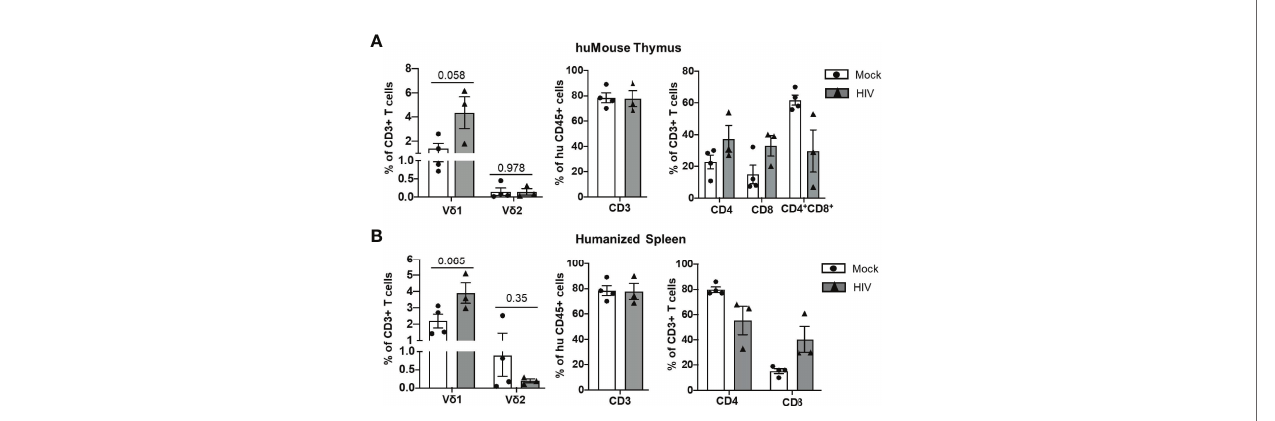
FIGURE 4 | T cell number is altered in lymphoid tissue of HIV-infected BLT huMice. (A, B) Quanti fi cation of human T cell subsets, gd T cells and ab T cells in human thymus and humanized spleen tissue of HIV-infected (n = 3 biological replicates) and non-infected (n = 4 biological replicates) BLT huMice at 4-6 weeks post-infection. Data are presented as mean values ± SEM. P values <0.05 were considered statistically signi fi cant as determined using an unpaired, 2-tailed Student ’ s